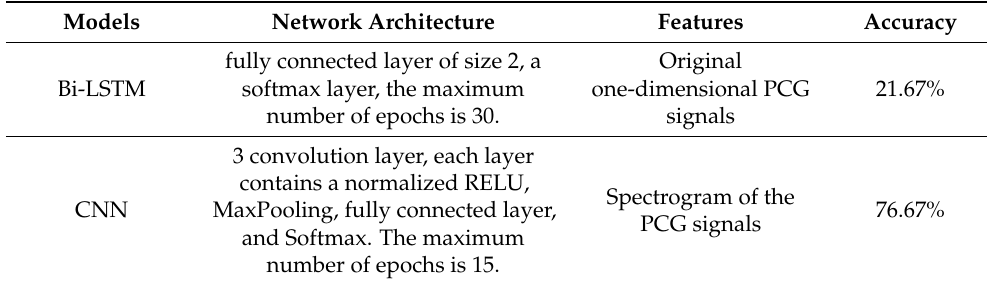
Table 8. Results for multiple class classifications based on other deep-learning